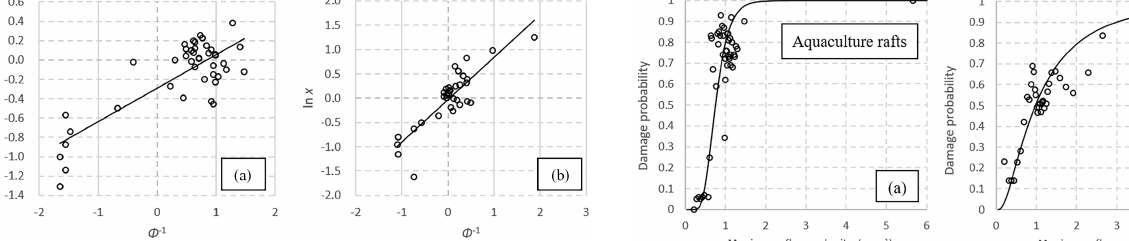
Figure 15. Tsunami fragility functions for completely damaged (a) aquaculture rafts and (b) eelgrass based on data from Man- gokuura